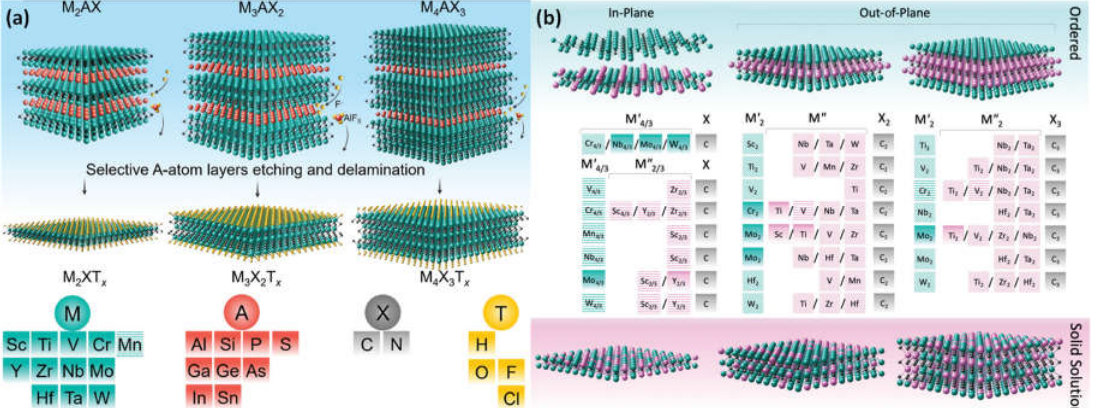
Figure 3. ( a ) After the production of surface terminations (yellow atoms) and the A-group layers were etched selectively (red atoms), three different mono-M MAX phases—M 2 AX, M 3 AX 2 , and M 4 AX 3 —MXenes were produced. M, A, X, and T components that could be present in the MAX and MXene phases; ( b ) the synthesized M 2 X, M 3 X 2 , and M 4 X 3 MXenes, which are double transition metals (DTM). The transition metals M′ and M′′ are represented by the green and purple elements, correspondingly. Both the in-plane divacancy order (M′ 4/3 X) and the in-plane order (M′ 4/3 M′′ 2/3 X). The order that is out of a plane (M′ 2 M′′X 2 and M′ 2 M′′ 2 X 3 ). M′ and M′′ transition metals are dispersed throughout the disordered MXenes in solid solutions. Additionally, solid solution (Mo 0.8 V 0.2 ) 5 C 4 T x was prepared successfully; however, it has not been shown for simplicity's sake. Reproduced with permission from reference [29].